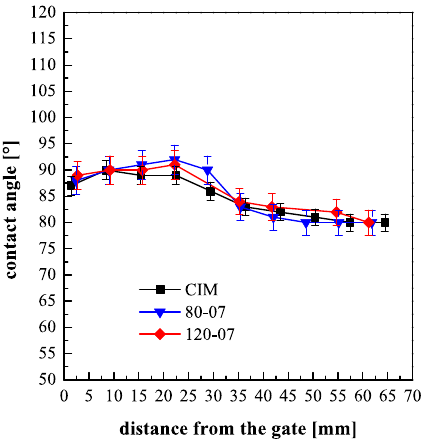
Figure 3. Contact angles of the molded samples obtained with CIM and different cavity surface Figure 3. Contactanglesof themoldedsamplesobtained with CIManddifferentcavitysurfacetemperature, temperature, keeping active the heating device only during the filling. keeping active the heating device only during the